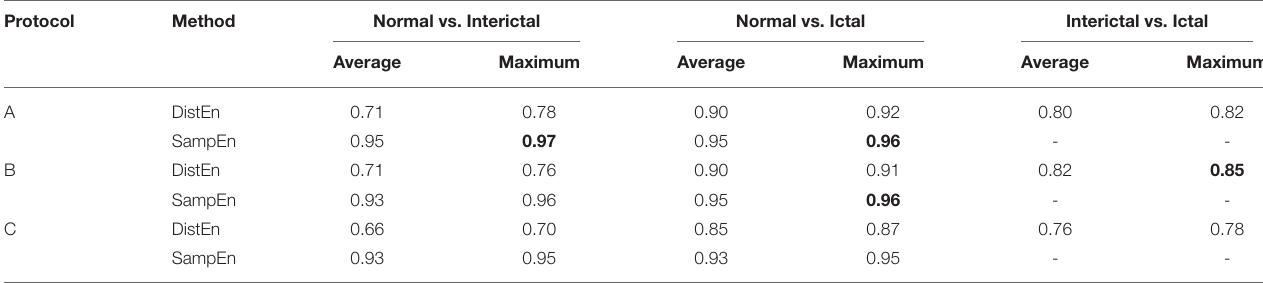
TABLE 3 | Average and maximum Area under the ROC curves (AUC) values of DistEn and SampEn for different classification problems under different analyzing protocols. Protocol